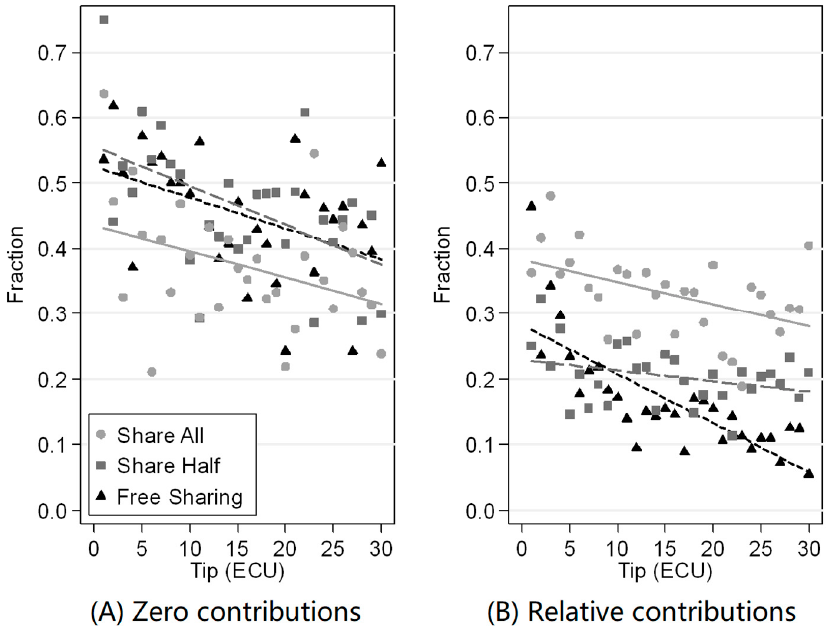
Figure 3. Linear trends. Free Sharing: Black triangles, short-dashed lines; Share Half: Dark gray squares, long-dashed lines; Share All: Light gray circles, solid line. ( A ) The probability of a waiter contributing nothing was higher for low tips than for high tips. ( B ) The mean fraction of positive tip contributed by waiters was higher for low tips than for high tips.